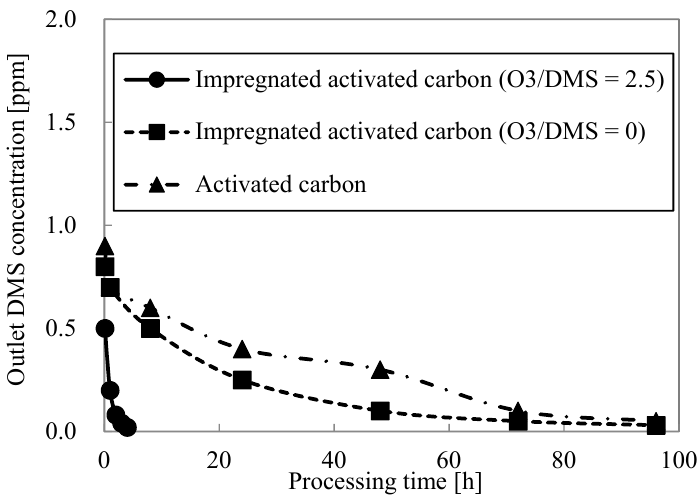
Figure 12. The time variations of outlet DMS concentration of adsorbents after adsorption experiment by air flowing without generation of DMS and ozone. Table 6. Desorption ratio of each adsorbents.